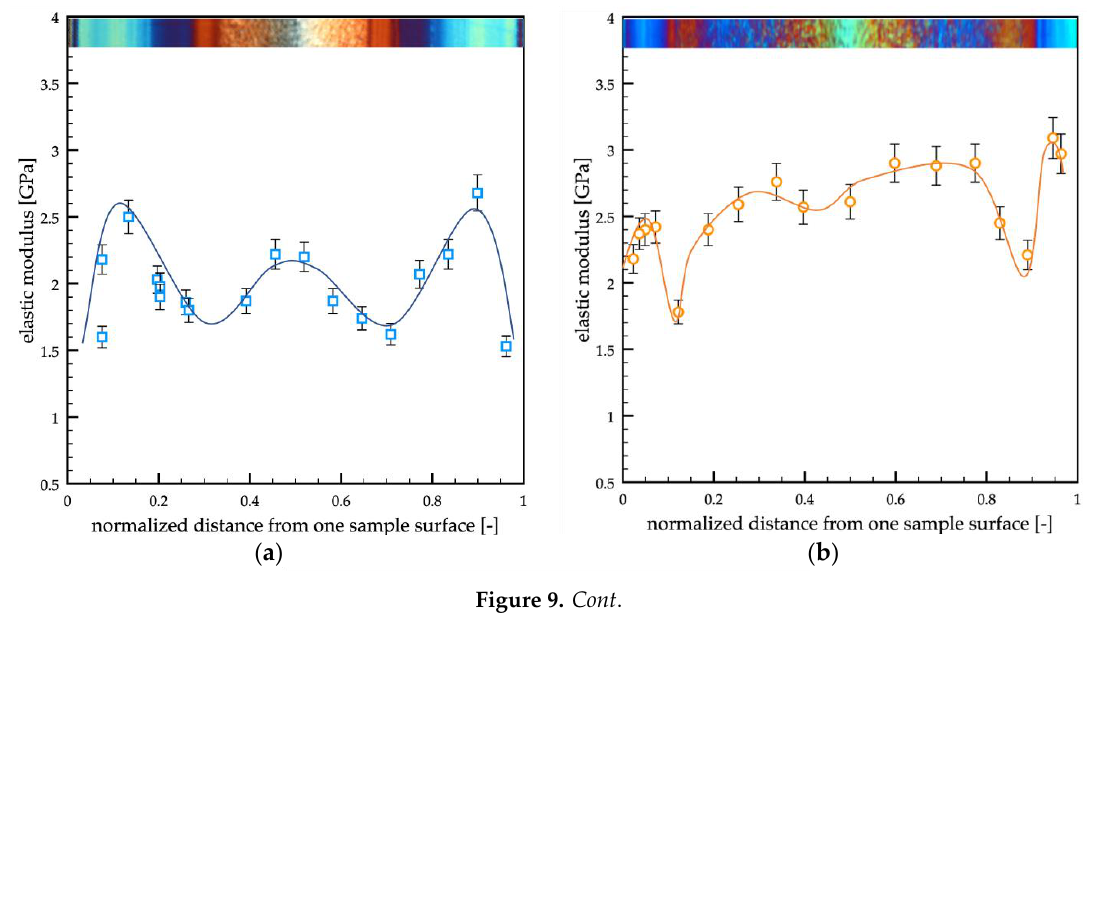
( c ) Figure 9. Elastic modulus distributions measured with the HarmoniX technique along the thickness of the ( a ) passive, ( b ) A, and ( c ) B sample. The passive sample showed two maxima of the elastic modulus in the shear regions, the lowest values could be detected at the sample surface and in the transition regions, and the core was characterized by intermediate values of the elastic modulus. The samples A and B showed similar trends of the elastic modulus distribution. Furthermore, they were characterized by higher values of the elastic modulus with respect to the passive sample. The high values of the elastic modulus characteristic of the shear region moved toward the sample surface, accordingly with the reduction of the shear layer thickness due to the increase in the cavity surface temperature. 5. Discussion Figure 10 shows the WAXS analyses at different distances from the sample surface for the passive, A, and B cases. The orange borders delimit the regions with a high orientation level.